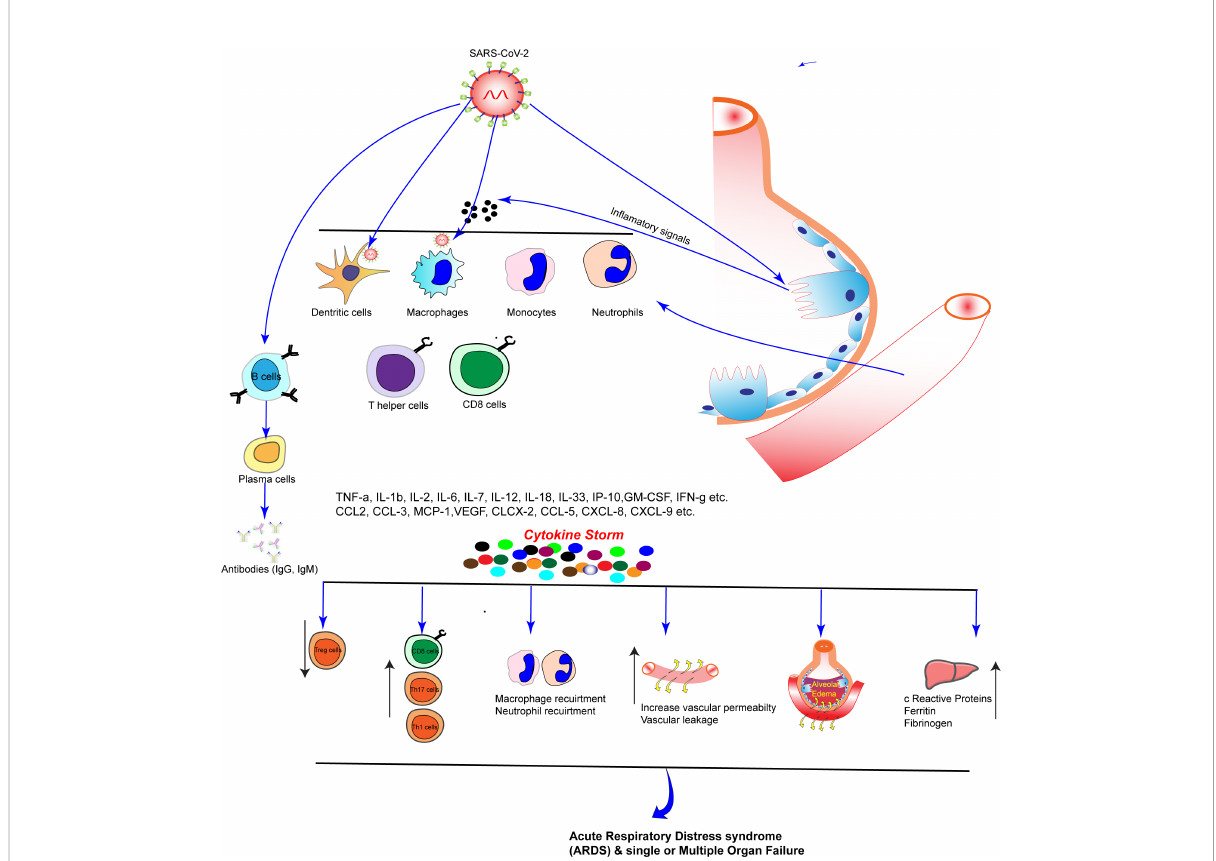
FIGURE 2 Recruitments of immune cells and damage of Lung epithelium and cytokine storm: SARS-CoV-2 enter into the cell by binding to the ACE2 receptor present on the host cell membrane. As the virus replicates in the lung cells and damage lung epithelium. Damaged lung epithelium cell secretes in fl ammatory signals and immune cells recruited in lung blood vessels which secrete pro-in fl ammatory cytokines and chemokines, including IL-6, IL-10, MIP1- a , MIP1-1 b , and MCP-1, are secreted by adjoining epithelial cells, alveolar macrophages, and endothelial cells. As a result of these cytokines storm happens and increased blood vessels permeability, accumulation of fl uid in the lung, hypoxia and ultimately acute respiratory distress syndrome (ARDS) and multiple organ